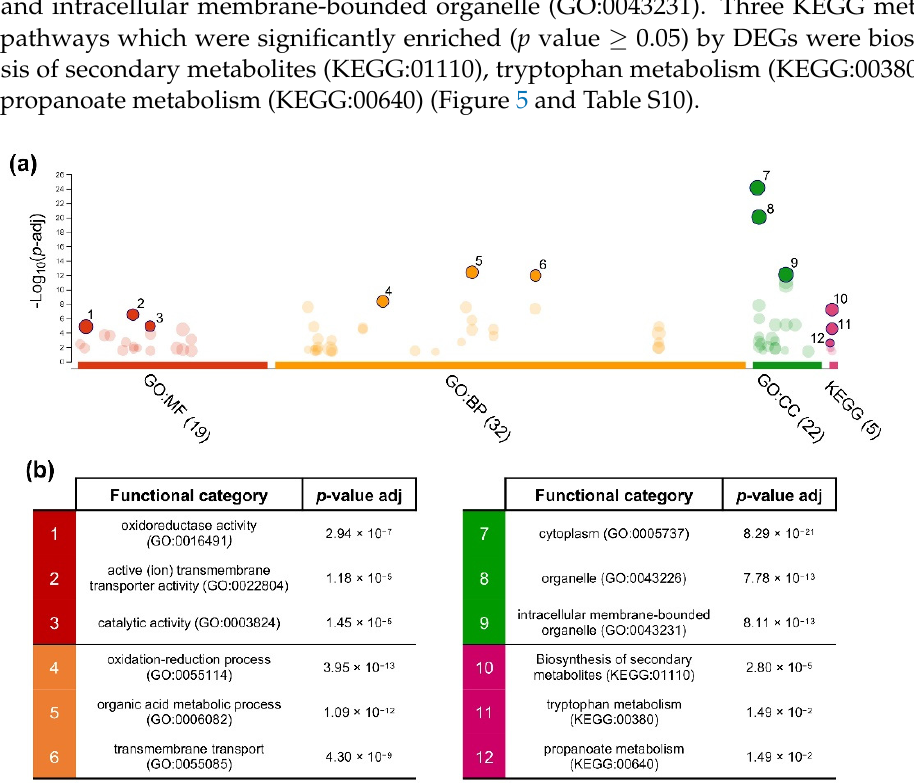
Figure 5. Enrichment of the GO terms and KEGG metabolic pathways by DEGs responsive to Cu-NPs. ( a ) Manhattan plot illustrating the significantly enriched (g: SCS threshold, p value ≤ 0.05) terms. The top three terms (solid colored dots) were numbered to distinguish them from the rest (dimmed colored dots). The name of each of these categories and its statistical significance are also shown ( b ).